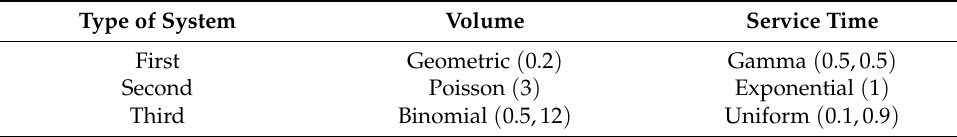
Table 1. The laws of parameter distributions for systems of various